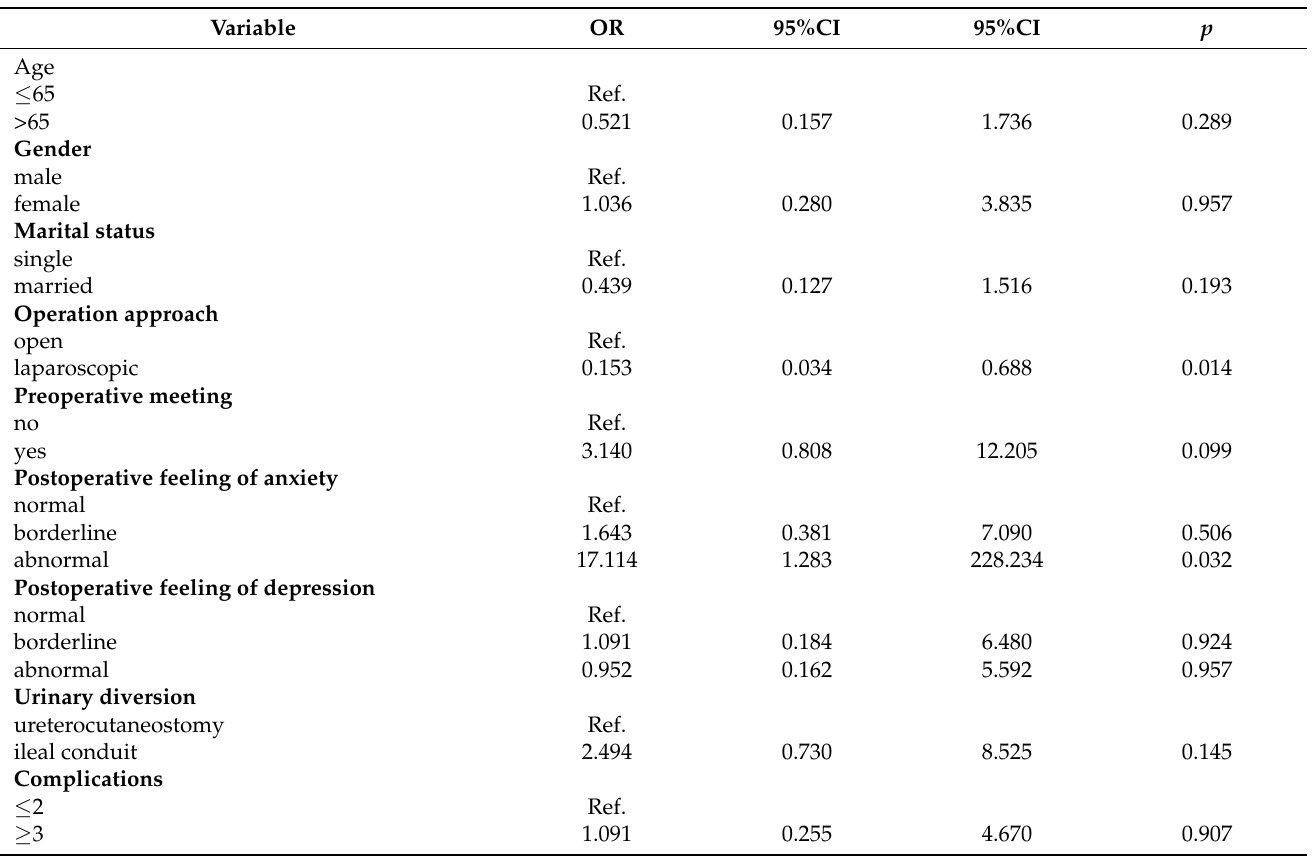
Table 4. Multivariate analysis of clinical factors associated with hospital stay ≥ 7 days (generalized nonlinear model, multivariate logistic